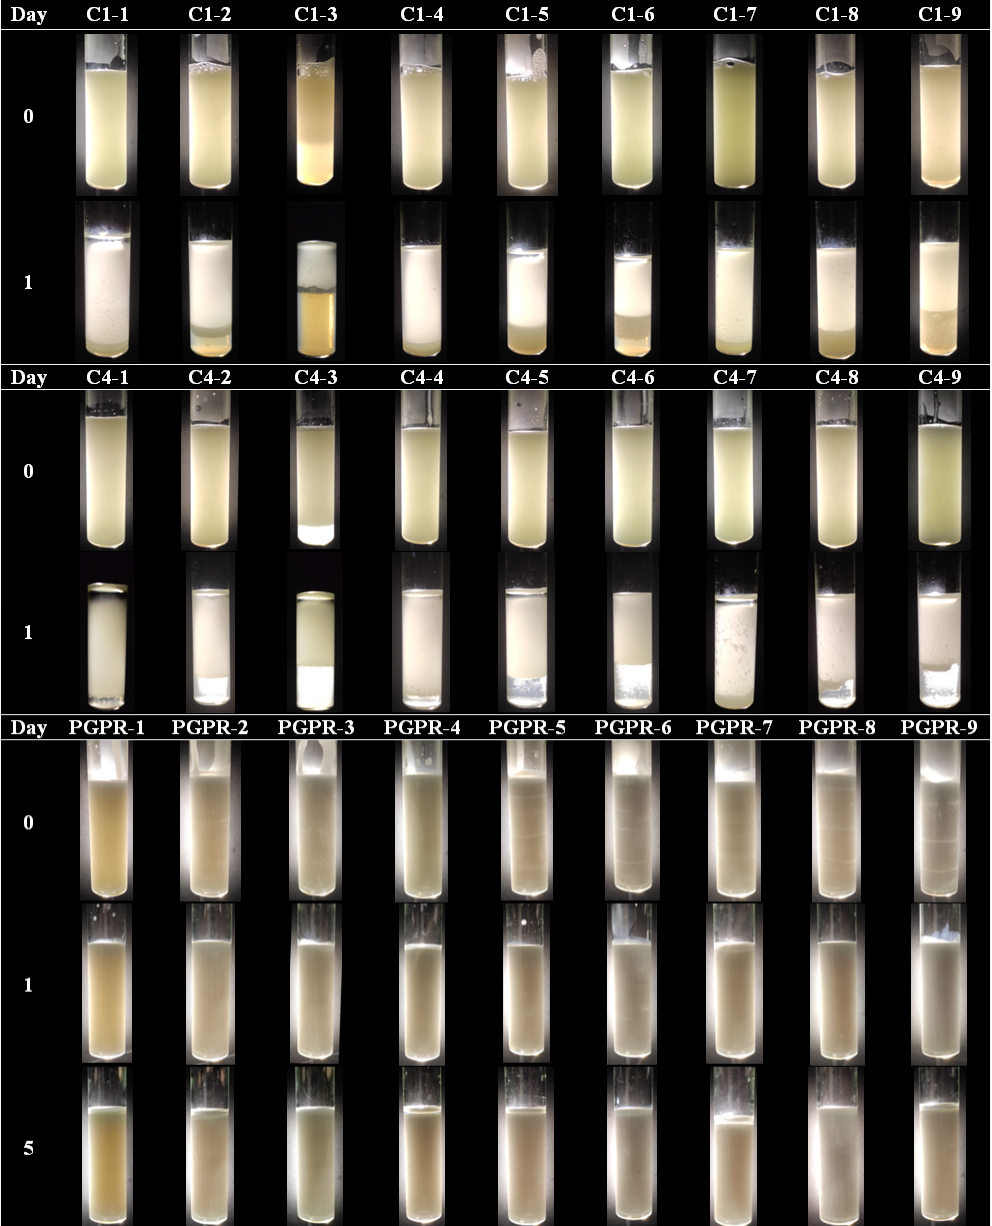
Figure 4. The gravimetric stability of W/O emulsions stabilized with Crill™ 1, Crill™ 4, and PGPR.